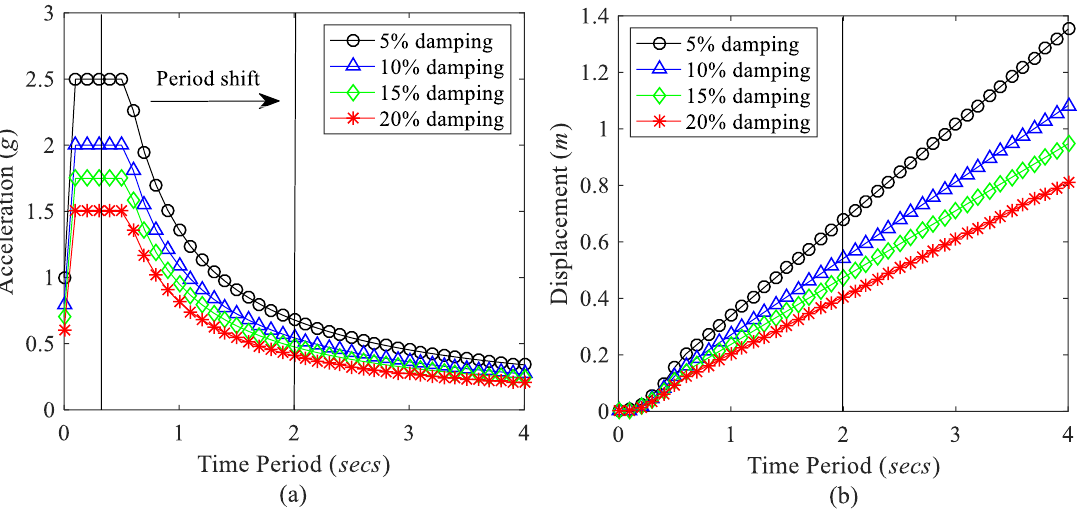
Fig. 1. (a) Acceleration spectra (b) Displacement spectra for 5, 10, 15 and 20%